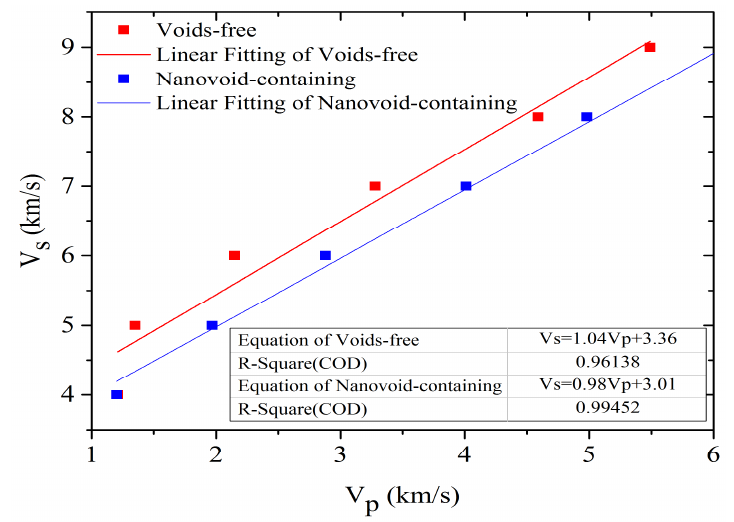
Figure 2. Relationship between the shock wave velocity Vs and the particle velocity V p for the void-free system and the nanovoid-containing system. There will be slight differences in the speed of transmission between the two